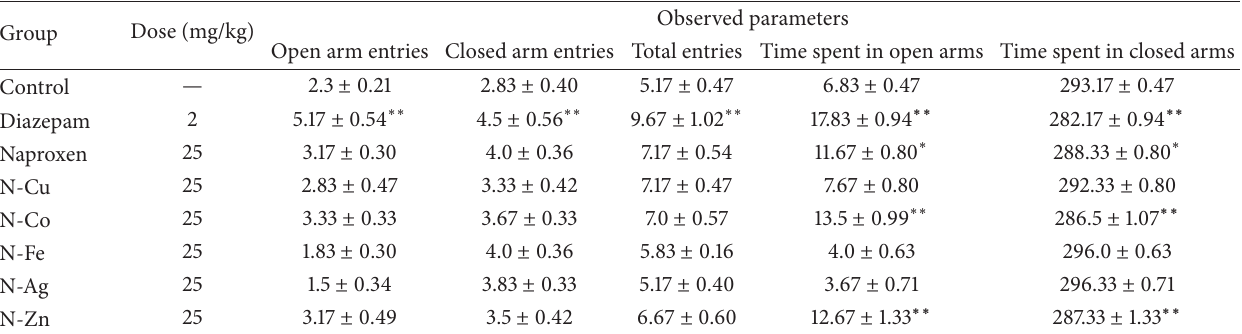
Table 3: Effect of naproxen and its metal complexes on the number of entries and time spent in elevated plus maze in acute study.